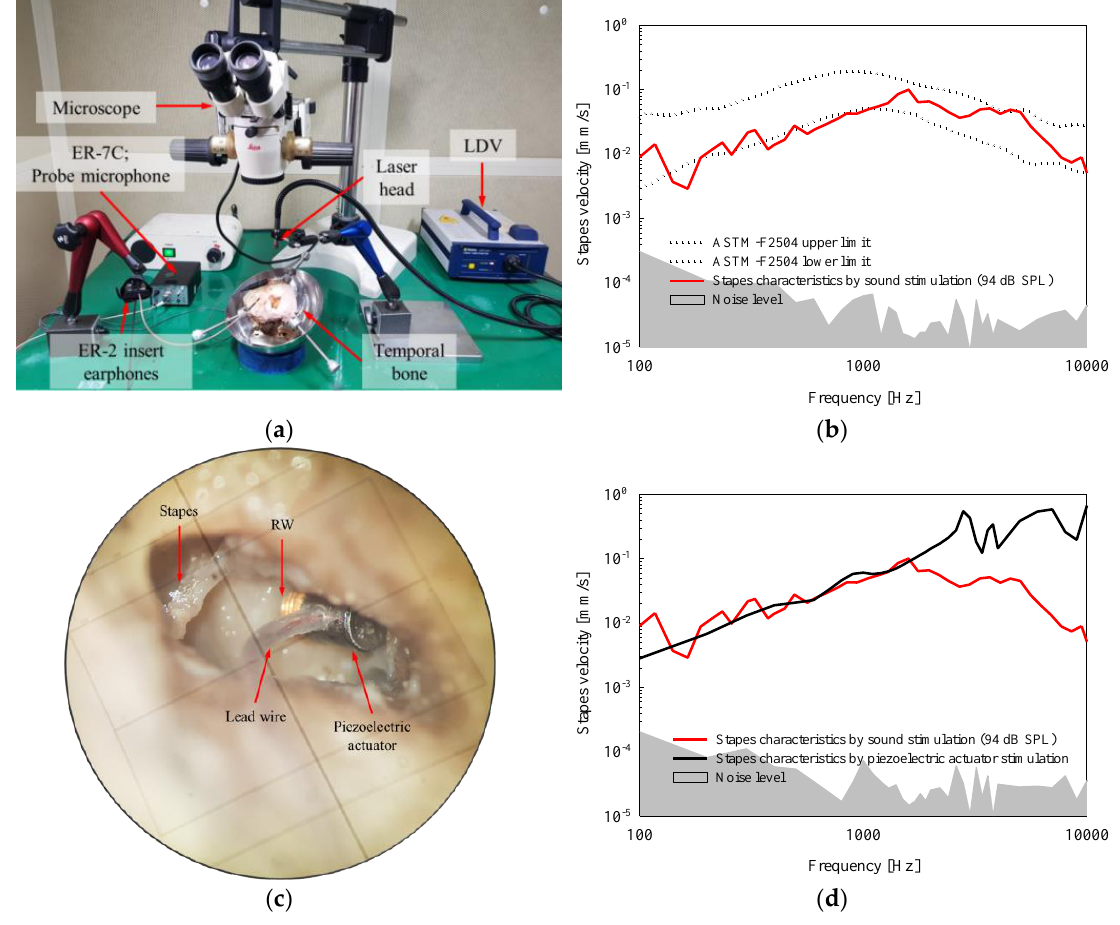
Figure 8. ( a ) Setup of measuring equipment for cadaveric experiment; ( b ) stapes vibrational characteristics upon sound stimulation (sound pressure level of 94 dB); ( c ) piezoelectric actuator implanted in the RW niche; ( d ) stapes vibrational characteristics upon RW stimulation using the piezoelectric actuator (6 V).